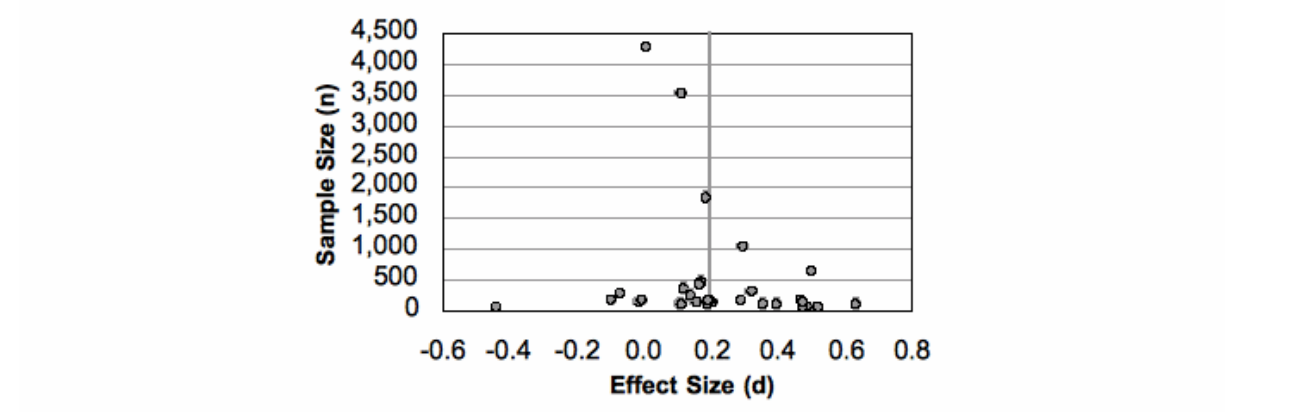
Figure 2. Funnel plot of